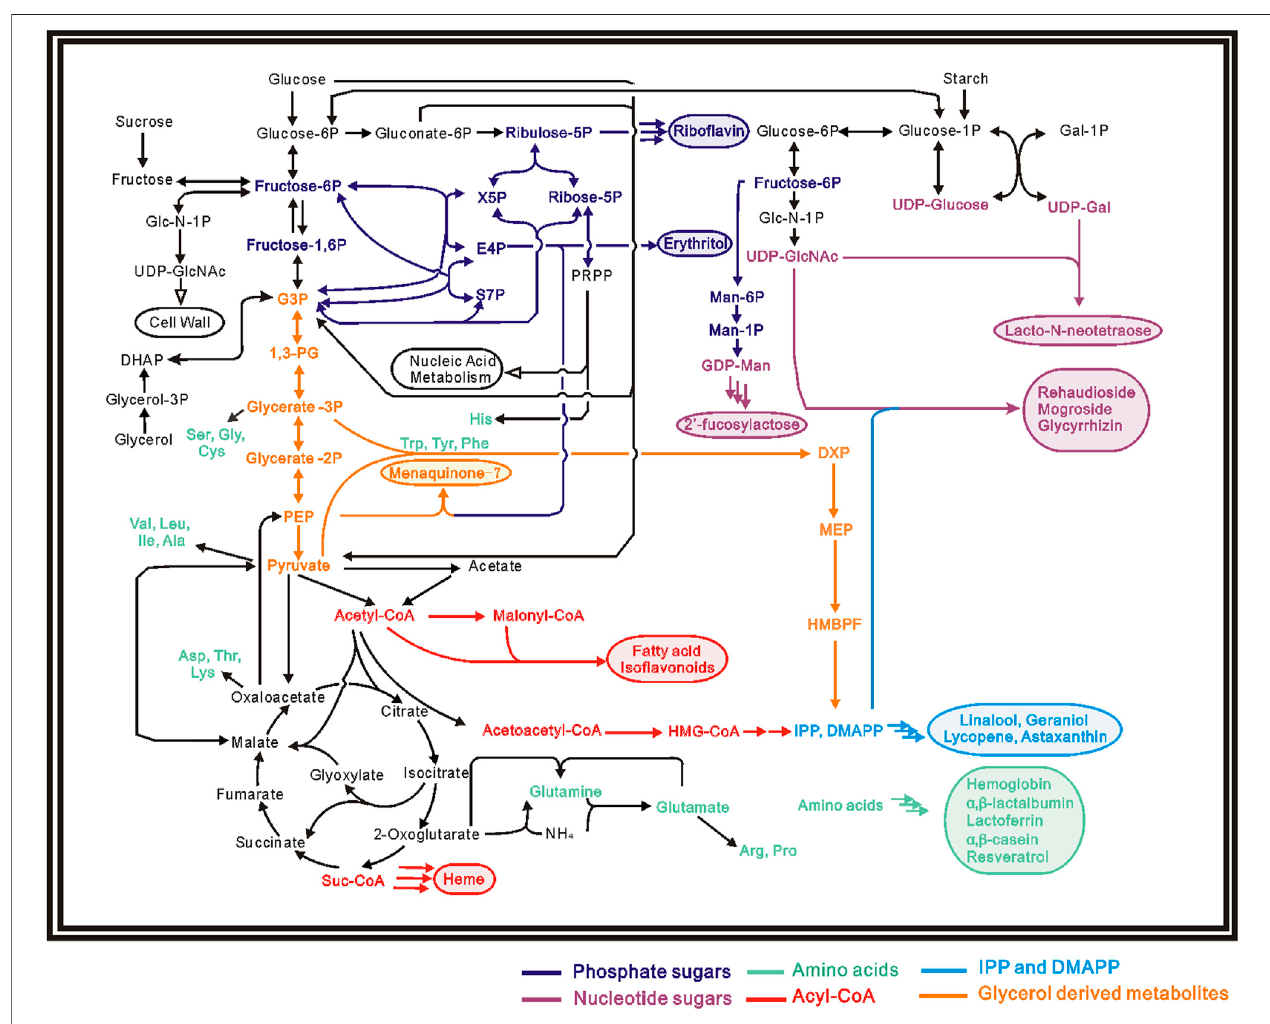
FIGURE 1 | Pathway map for several biosynthetic food components, products are shown in the same color with their corresponding precursors.